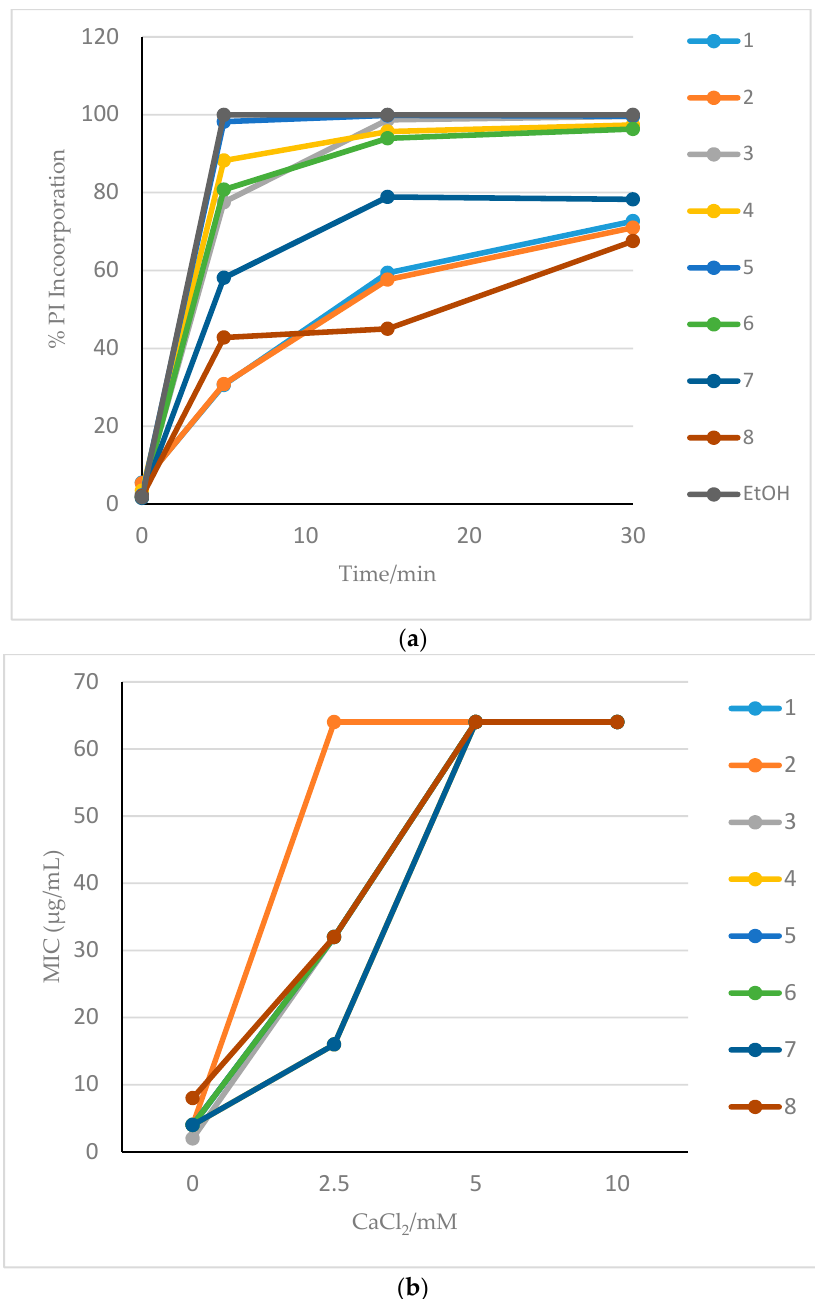
Figure 2. Membrane activity of potent HDP mimetics. ( a ) Propidium iodide (PI) incorporation in Candida albicans exposed to HDP mimetics. PI incorporation after 0–30 min treatments with 32 µg/mL of each HDP mimetic. 95% ethanol was used as a positive control, in which 100% PI entered the cell within 7 min. No PI was taken up in untreated yeast cells. ( b ) Calcium chloride inhibition of MIC of potent HDP mimetics. MIC assays were carried out in the presence of increasing concentrations of CaCl 2 .